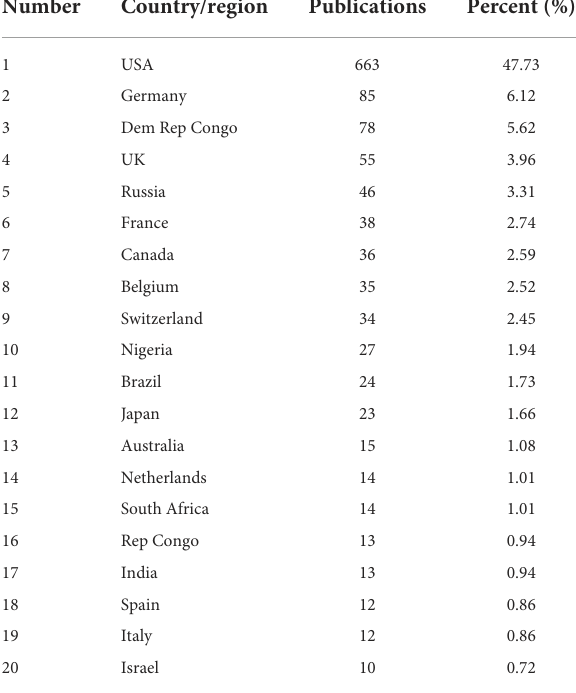
TABLE 2 Top 20 countries or regions contributing to publications in monkeypox